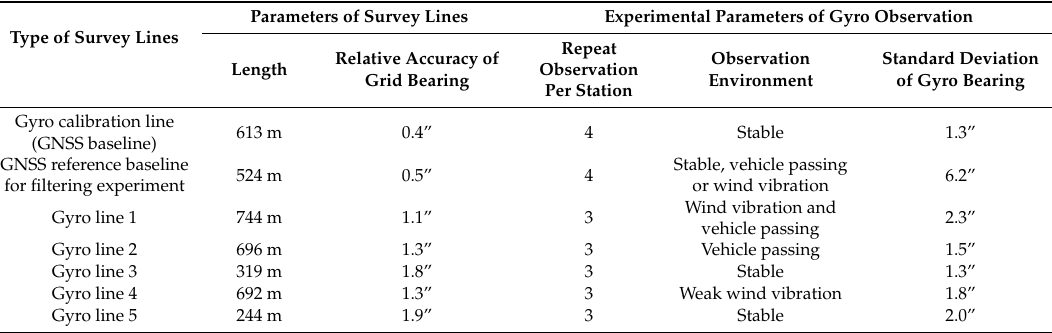
Table 2. Summary of the gyro observations in the experimental